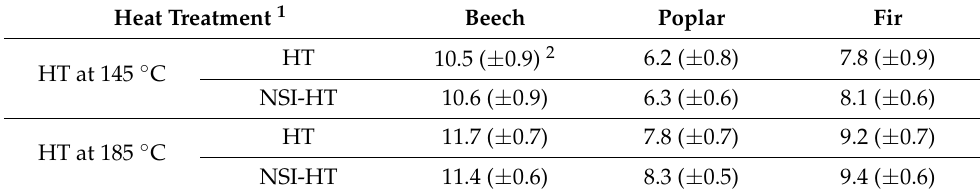
Table 3. Mass losses in the three wood species caused by heat treatments at 145 ◦ C and 185 ◦ C. Heat Treatment